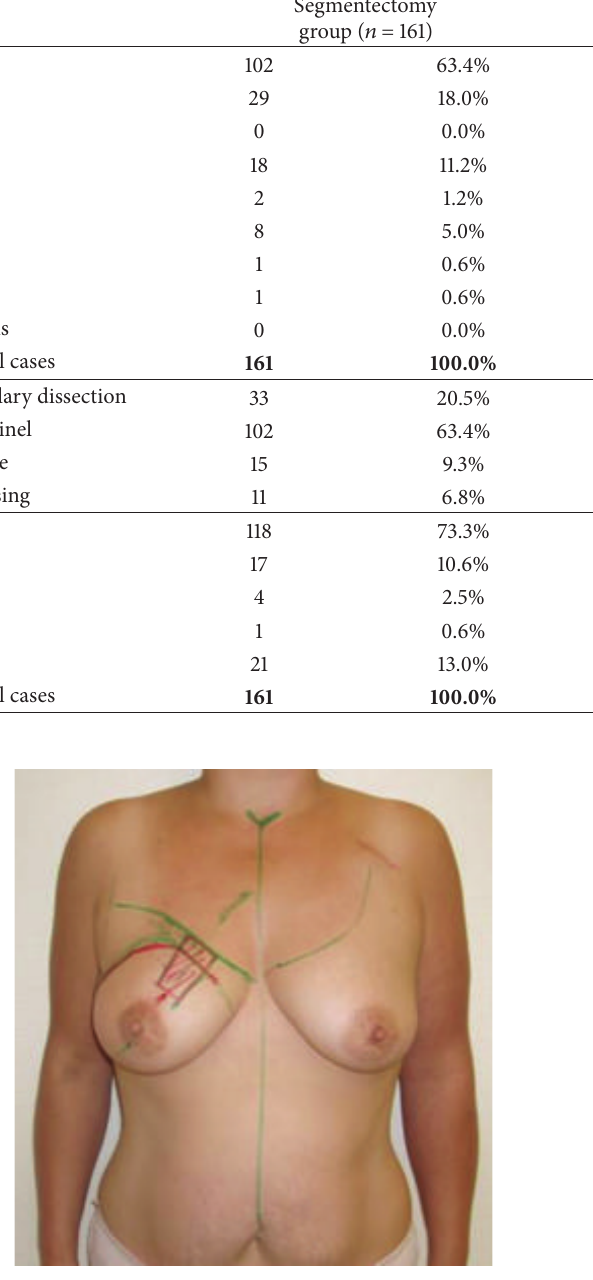
Figure 3: Patient of 46 years, pT2pN2, resection volume 55 g, cup 80C, frontal view.